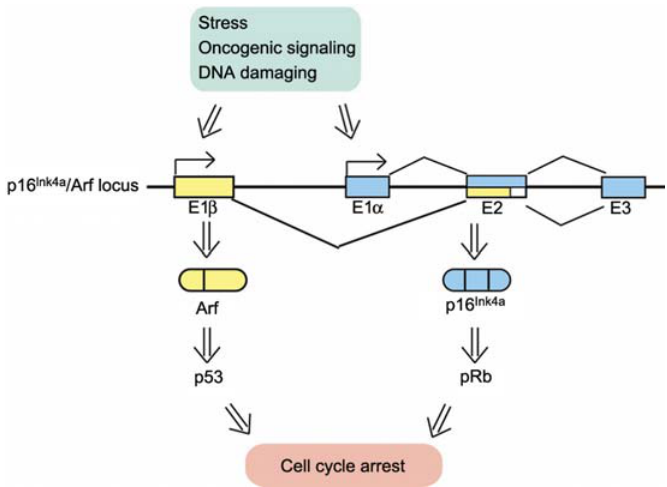
Figure 1 Schematic structure of the p16 Ink4a /Arf locus. Signaling from stress, oncogenic activation, and DNA damage activate transcription from Exon 1 b and Exon 1 a of Arf and p16 Ink4a , respectively. As a result of splicing, Arf (yellow) and p16 Ink4a (blue) share common Exon 2 and Exon 3 sequences but are translated from alternative open reading frames that code for different amino acid sequences. Arf and p16 Ink4a activate the p53 and pRb axes, respectively.